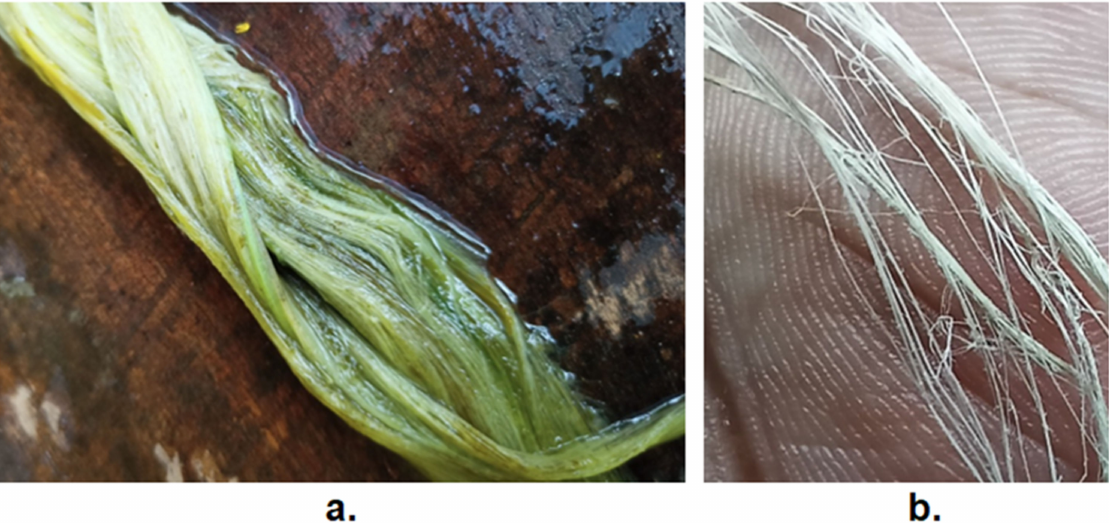
Figure 2. ( a ) Manually extracted fibers; ( b ) Extracted fibers after drying at ambient